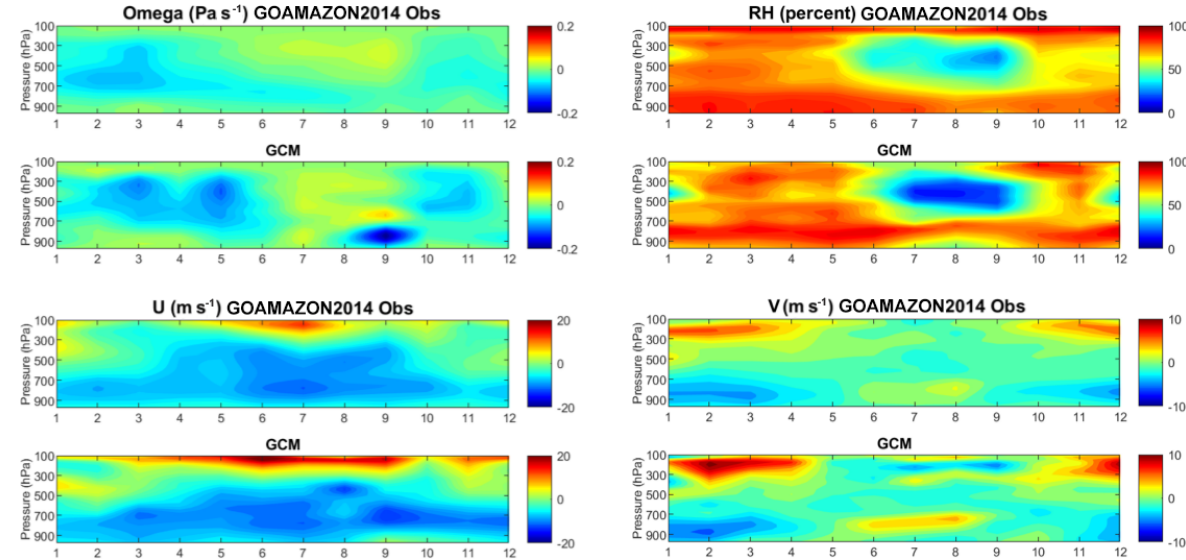
Figure 3. Annual cycle of observed versus E3SM simulated environmental states for the GOAMAZON location for large-scale vertical velocity (top two left panels), relative humidity (top two right panels), zonal wind (bottom two left panels) and meridional wind (bottom two right